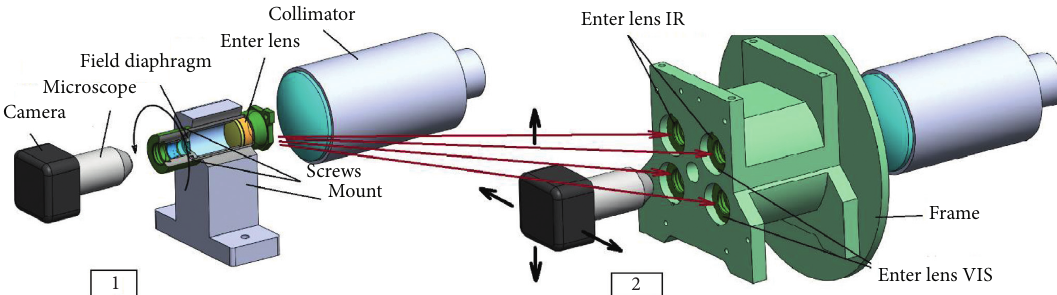
Figure 9: The bench of alignment of field of view of ScanPol PSA entrance lenses.